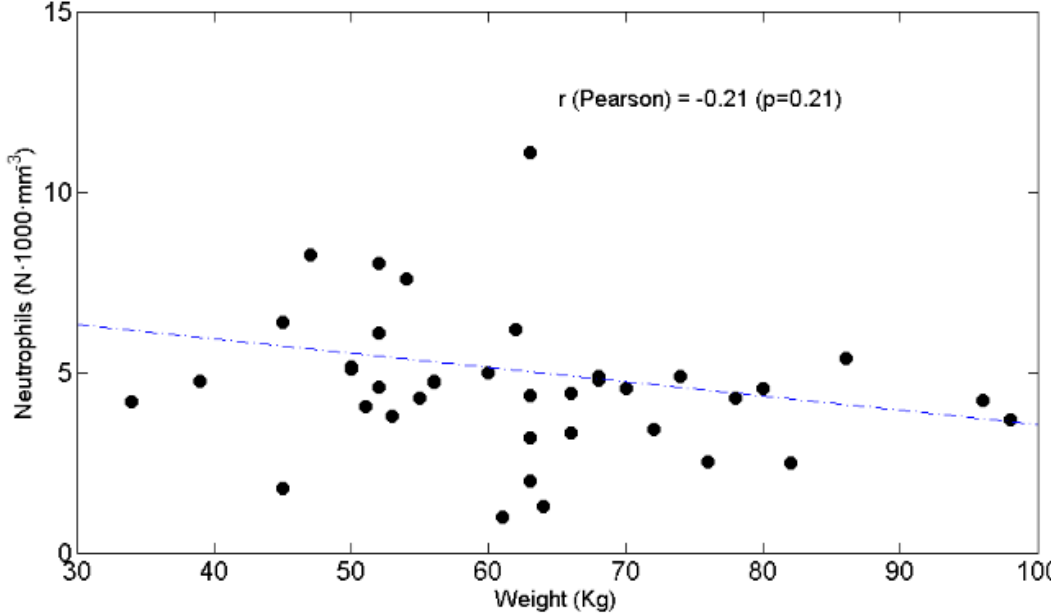
Figure 6. Scatter plot of the circulating neutrophils expressed as absolute value (y axis) as a function of weight (x axis). The value of Pearson’s correlation coefficient and corresponding p value are also reported. Figure 7. Blood neutrophils/lymphocytes ratio is inversely associated with Body Mass Index (kg/m 2 ).